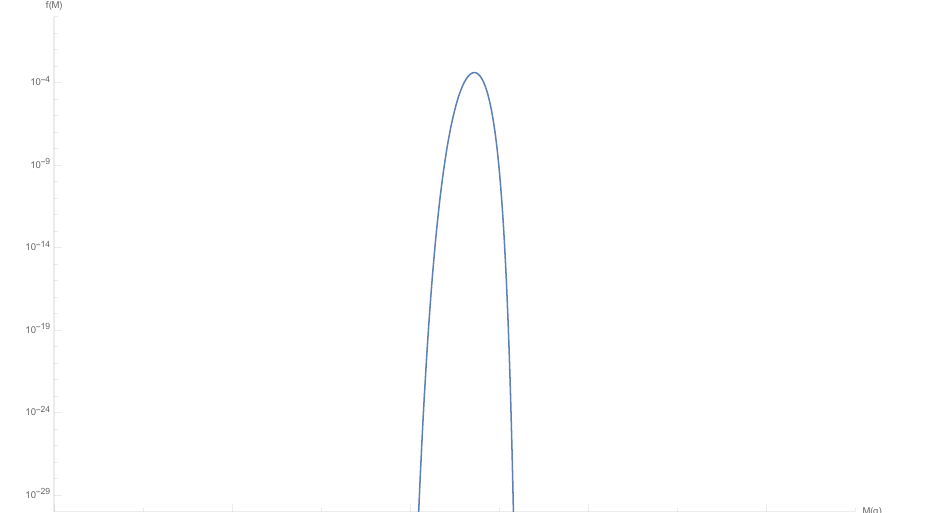
Figure 5 . This figure shows the fraction of PBH mass relative to dark matter in the present time coming up from the lower blue plot in figure 3, in terms of its mass with the parameters δ th = 0 . 5